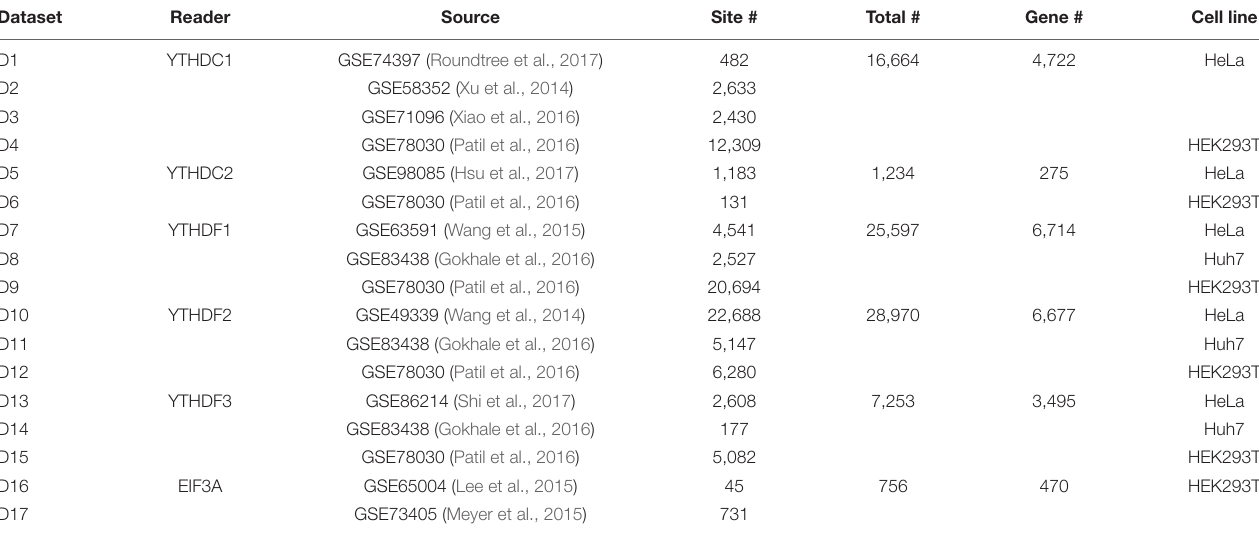
TABLE 2 | Target sites of m 6 A readers identified by Par-CLIP or iCLIP.